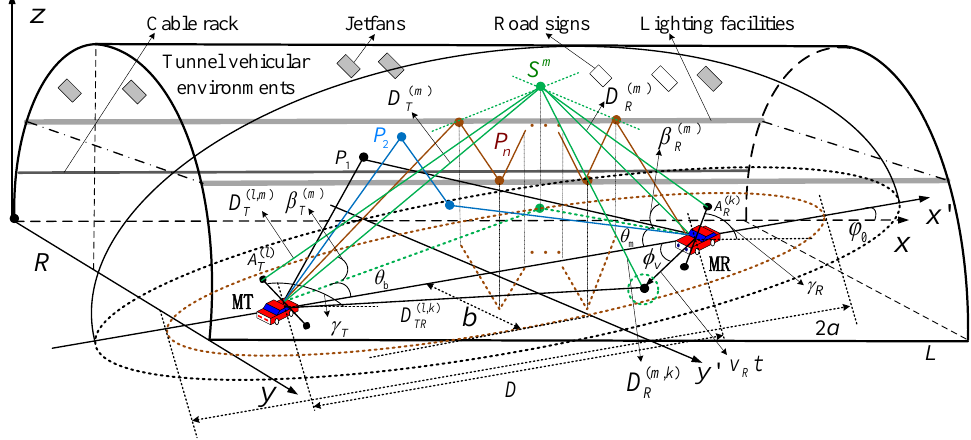
Figure 1. Proposed non-stationary geometry-based scattering channel model for tunnel V2V commu- nication